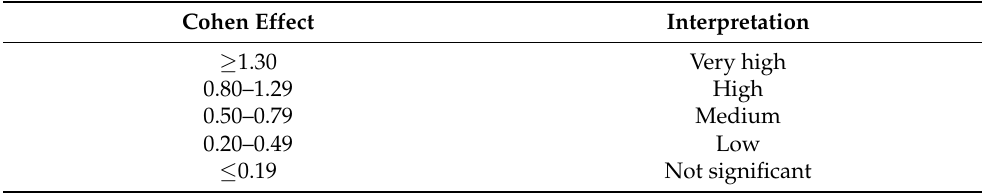
Table 11. Interpretation of the Cohen effect size measurements.